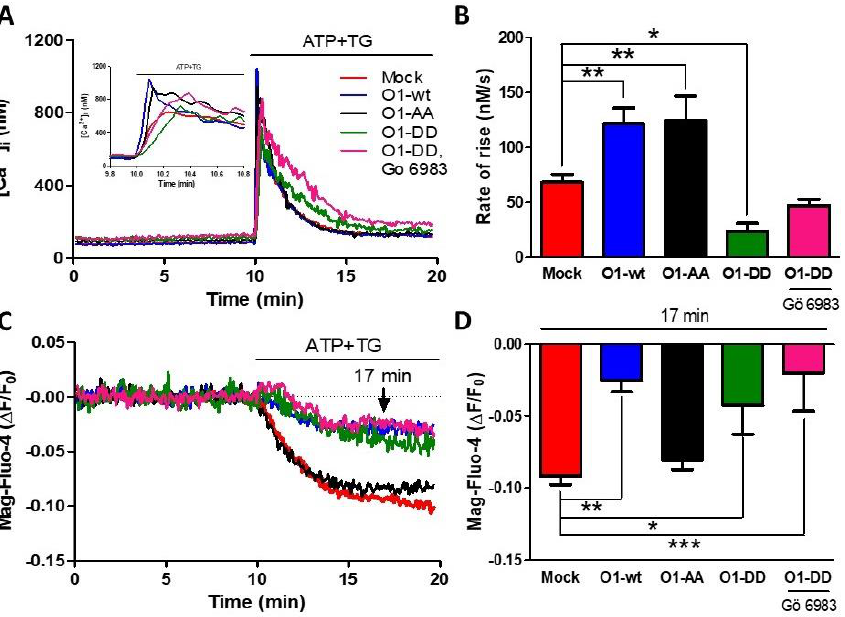
Figure 3. The S27/30A O1 mutant (O1-AA) increases while the S27/30D O1 mutant (O1-DD) inhibits the ATP and TG-induced rate of Ca 2+ release. ( A ) Time course of the changes in [Ca 2+ ] i induced by